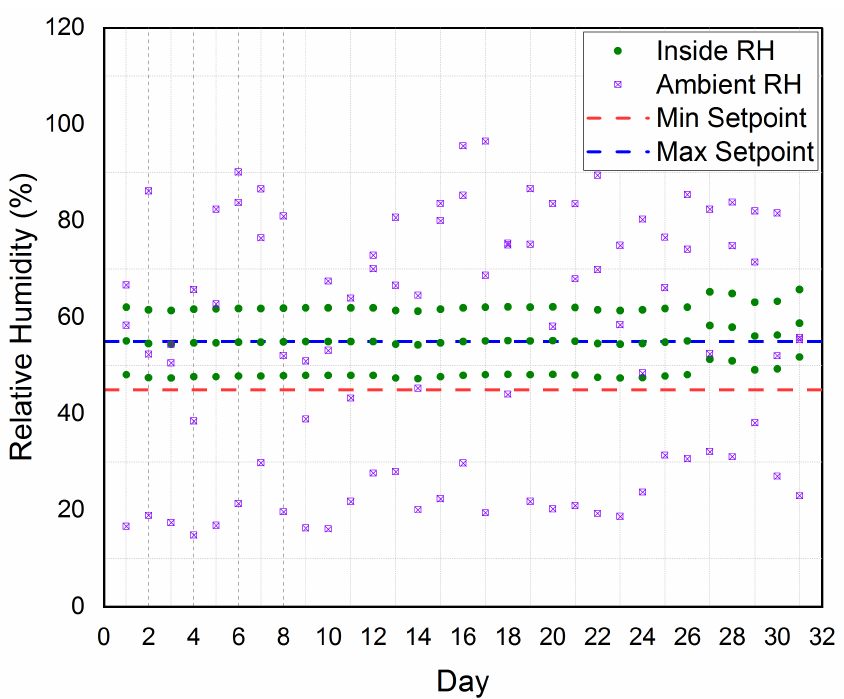
Figure 10. The three months average for inner greenhouse relative humidity (Inside RH) and outside relative humidity (Ambient RH) according to the minimum setpoint (Min Setpoint) and maximum setpoint (Max Setpoint) considered in our